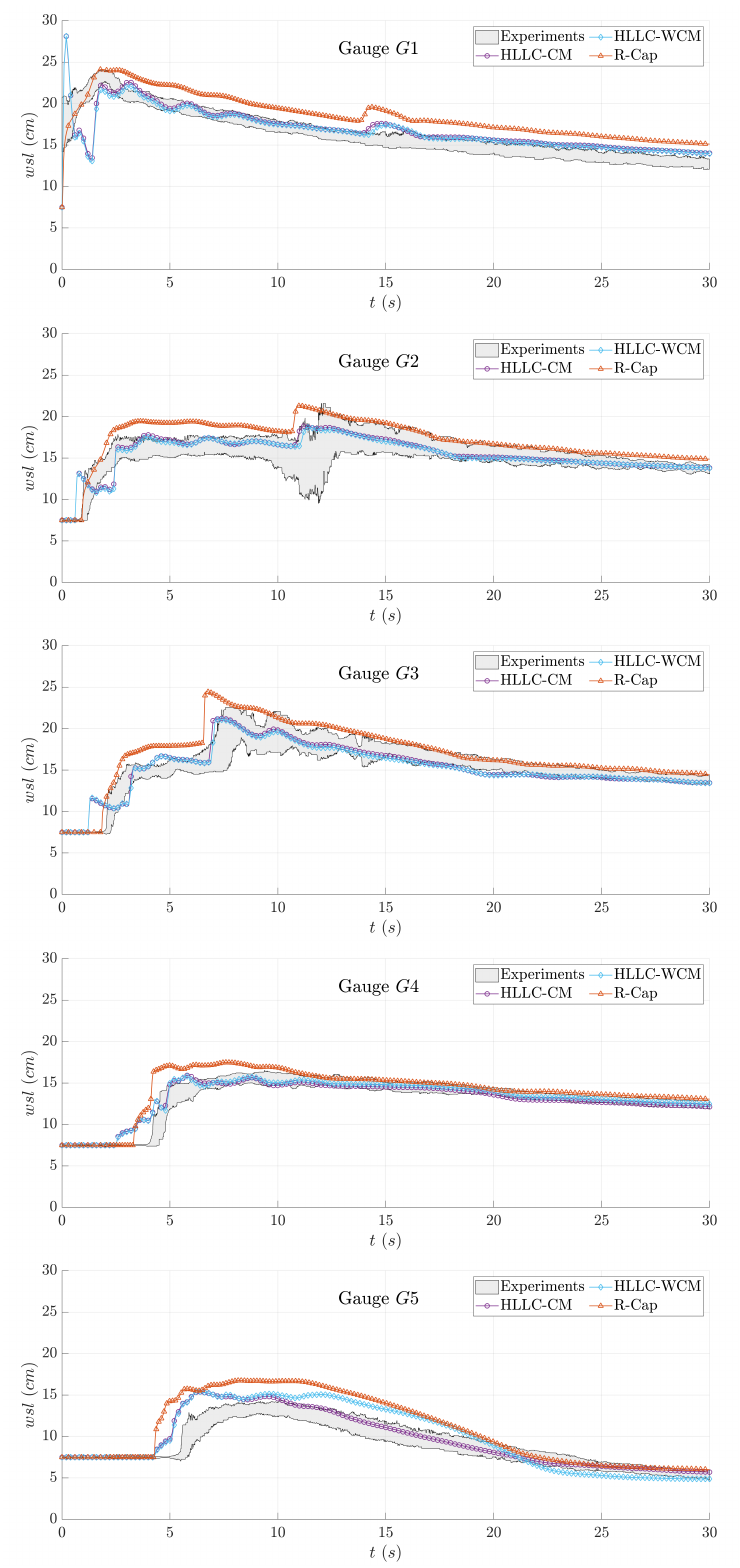
Figure 3. wsl (cm) at gauge points G 1, G 2, G 3, G 4, and G